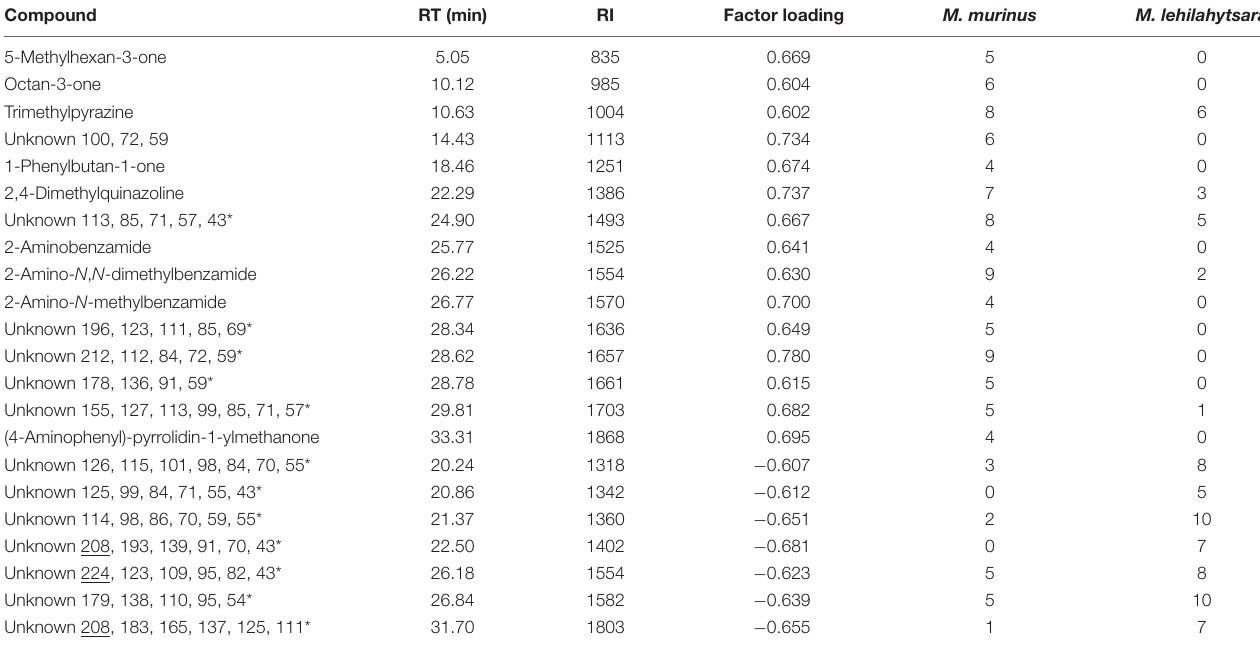
TABLE 3 | Compounds of the urine profiles of M. murinus and M. lehilahytsara that contributed substantially (factor loading < -0.6 or > + 0.6 on the factor with the highest statistical contribution: Factor 2) to the discrimination of the two species. Compound RT (min) RI Factor